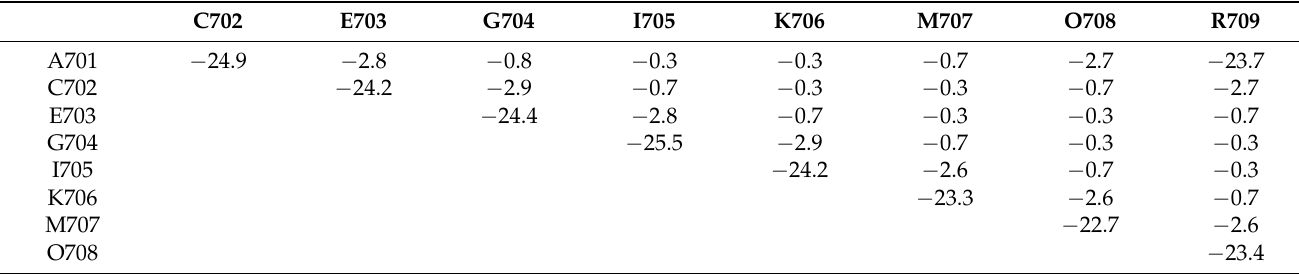
Table A3. Interaction energies between BChl molecules in the B800 ring, calculated in the dipole–dipole approximation. The Q y transition moments are considered to be collinear to the NB–ND direction of the porphyrin ring of BChl. The crystal data are taken from 2fkw.pdb